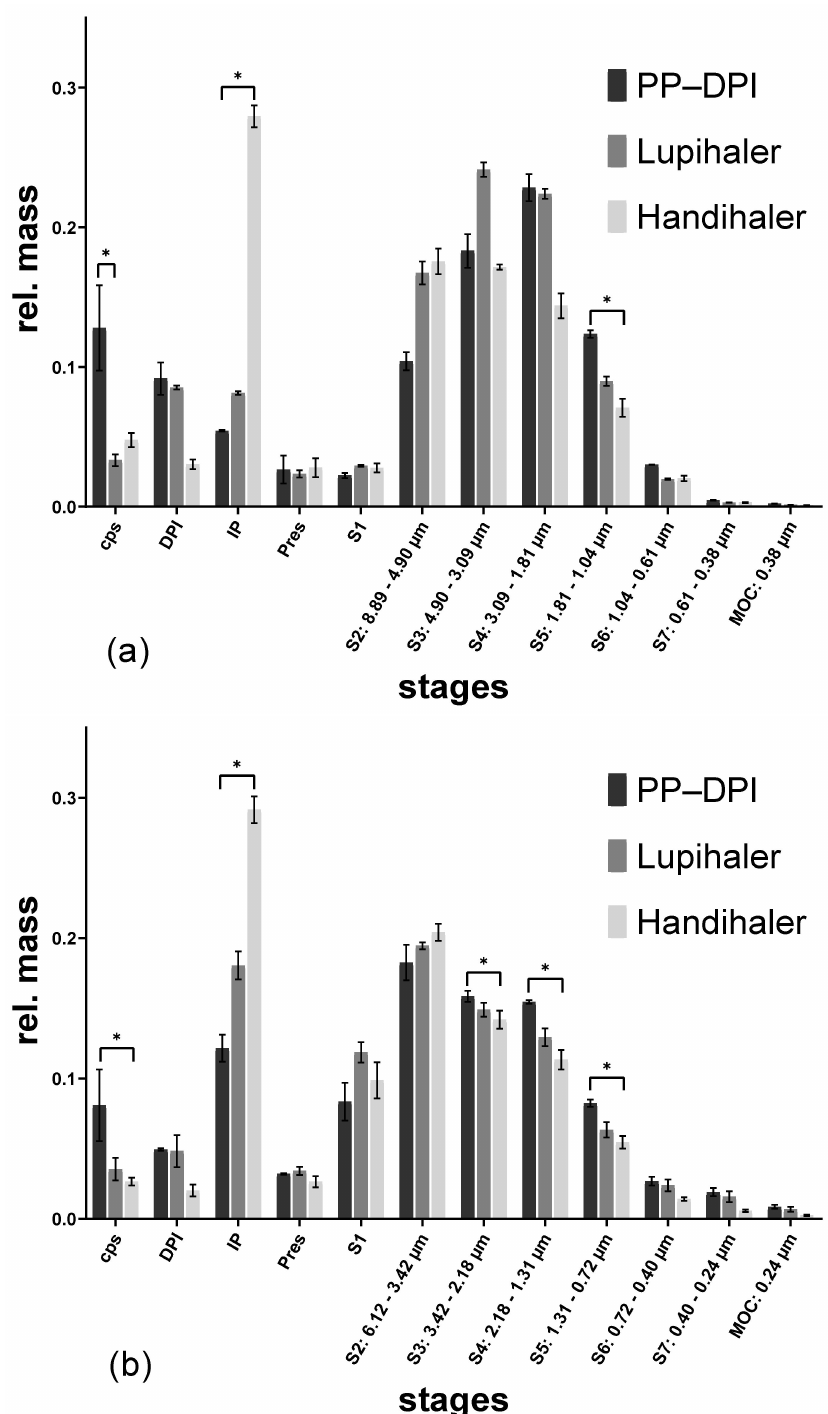
Figure 6. NGI results of the spray-dried rifampicin formulation actuated with different devices at different flow rates. ( a ) 50 L/min; ( b ) 100 L/min, (capsule = cps; dry powder inhaler = DPI; induction port = IP; preseparator = Pres), (* p <